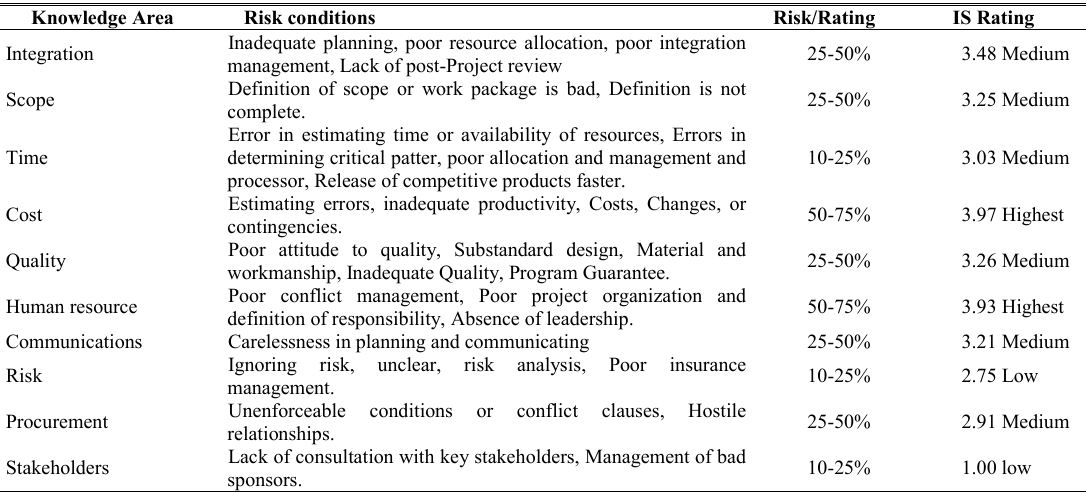
TABLE 3 P OTENTIAL NEGATIVE RISK CONDITION ASSOCIATED WITH EACH KNOWLEDGE